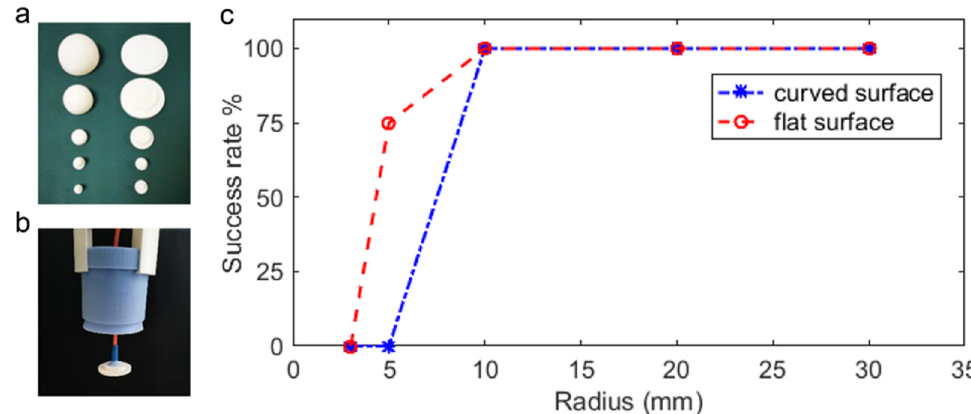
Figure 11. ( a ) Experimental objects for adsorption experiment of the detachable sucker. ( b ) The state of adsorbing an experimental object using the detachable sucker. ( c ) The success rate of picking up experimental objects using the detachable sucker.